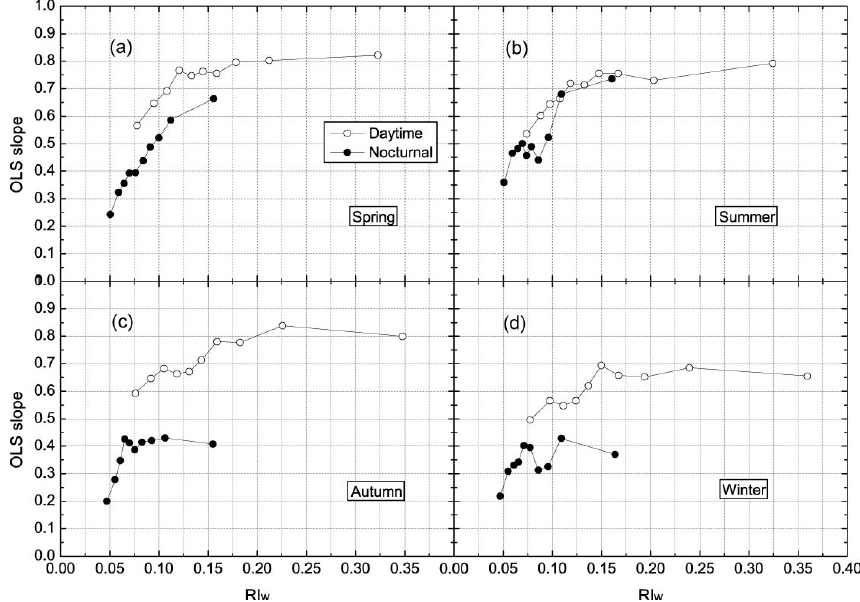
Fig. 12. Seasonal effect of relative turbulence intensity on EBC denoted as OLS slope over the native grassland of the semi-arid Loess Plateau, in (a) spring, (b) summer, (c) autumn, and (d)